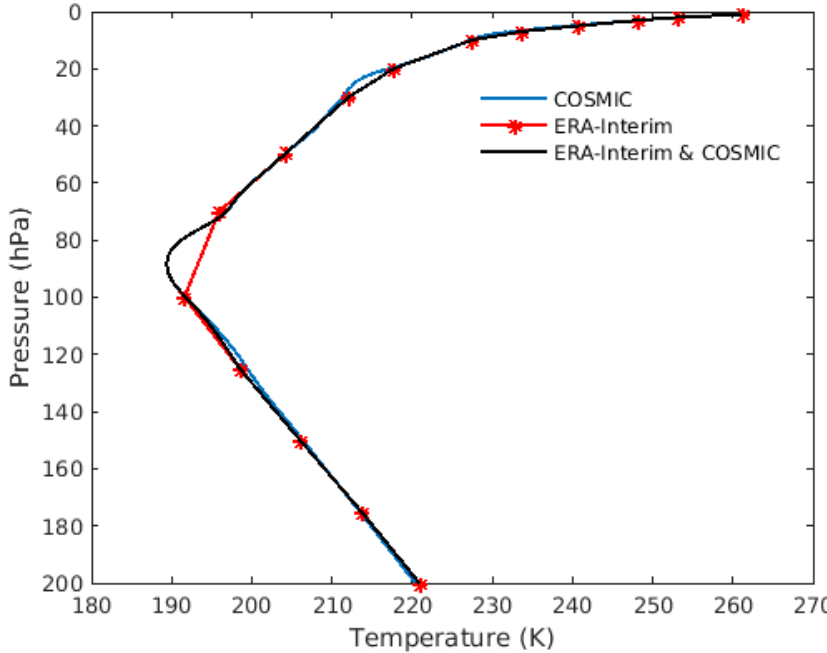
Figure 1. An example of the merged temperature profile (black) from the ERA-Interim (red) and COSMIC (blue) temperature profiles.